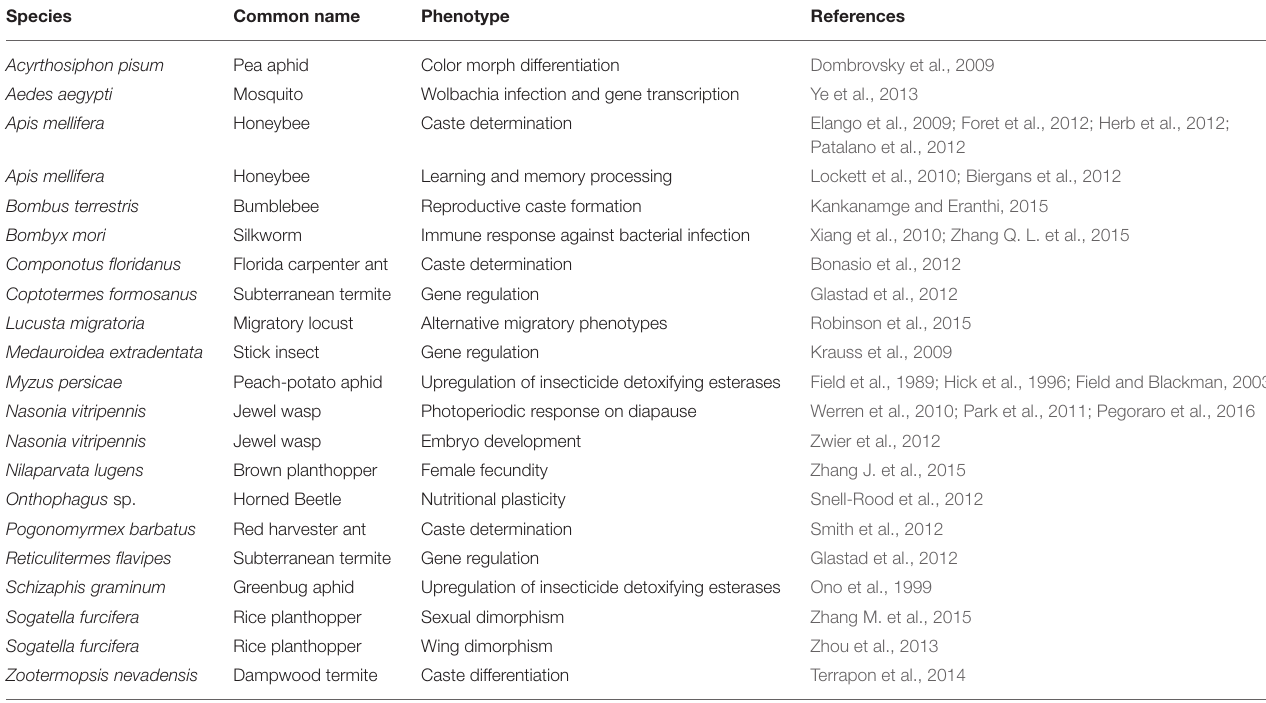
TABLE 1 | DNA methylation in various insects and its associated phenotypic